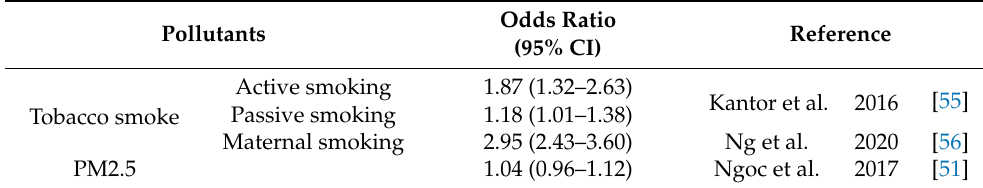
Table 2. Effects of air pollutants on the risk of atopic dermatitis (meta-analysis). Pollutants